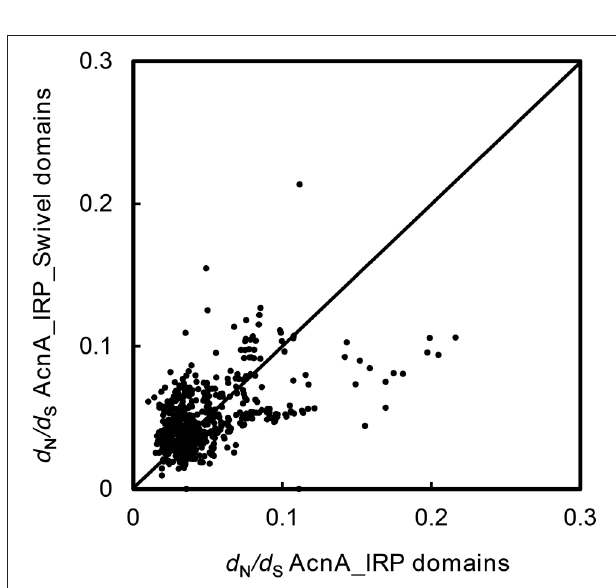
FIGURE 4 | Schematic representation of the duplication history of ACO genes in seed plants. The designation of each clade corresponds to the Figure 3 .